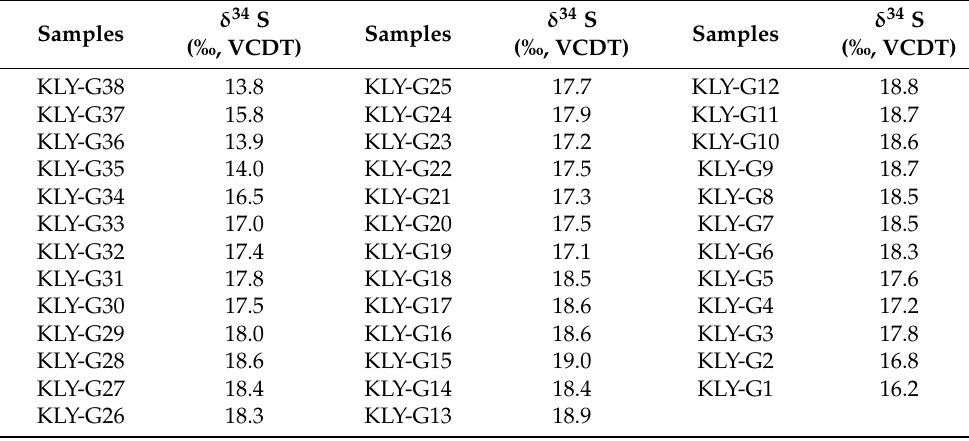
Table 2. Sulfur isotopic composition of gypsum in KLY outcrop in the